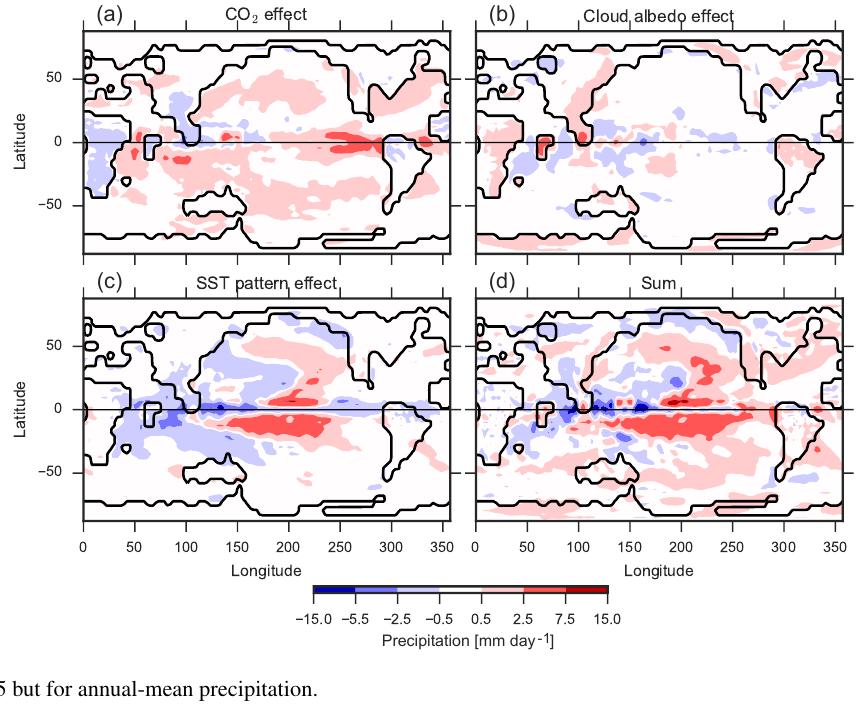
Figure 6. As in Fig. 5 but for annual-mean precipitation.